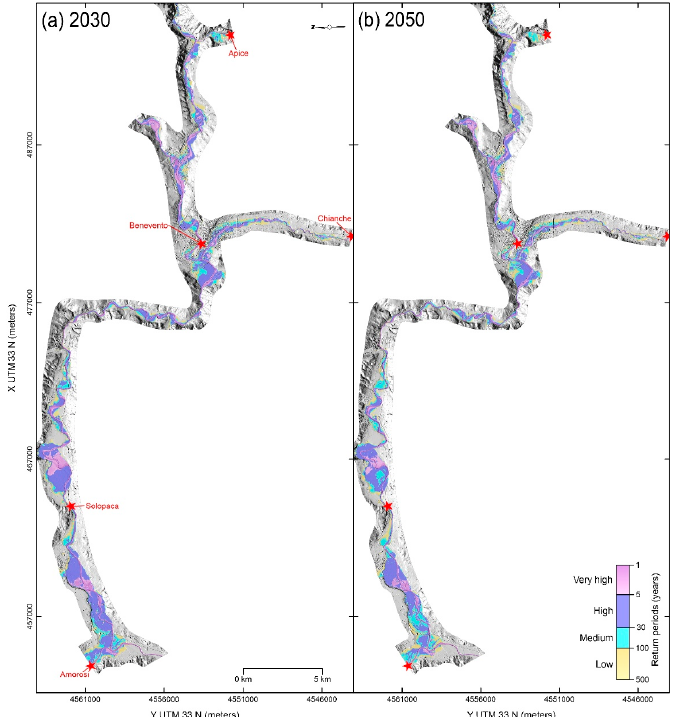
Figure 4. Flood hazard zonation for the two future ( a ): AD 2030; ( b ): AD 2050) flood scenarios. Red symbols indicate hydrometric stations considered in the analysis. UTM 33 N coordinates are shown at the bottom and left sides of the map.